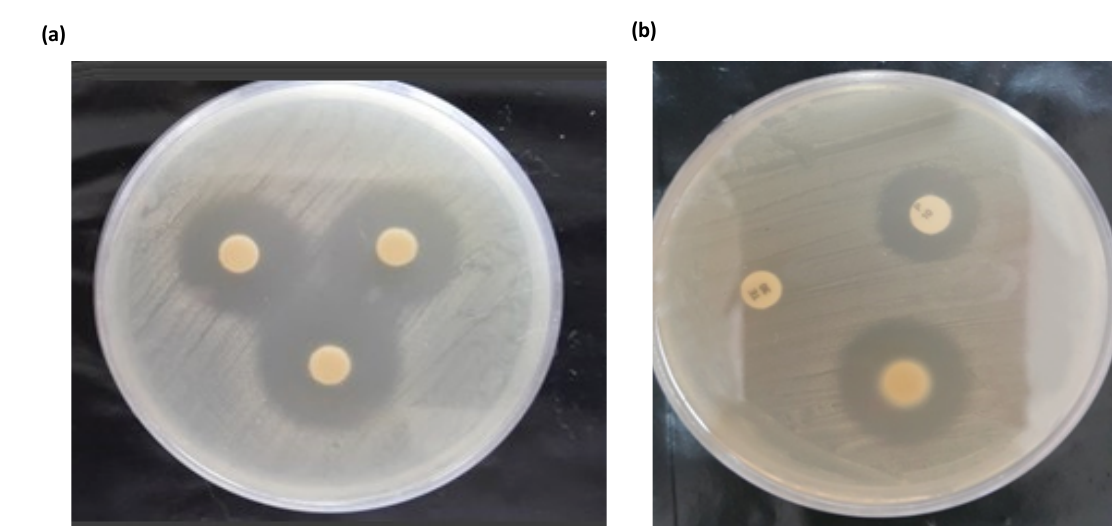
Figure 1. (a) The growth inhibition zone of aqueous-alcoholic extract of blackberry on Staphylococcus epidermidis and (b) the growth inhibition zone of aqueous extracts of Morus nigra , penicillin and tetracycline on Staphylococcus epidermis